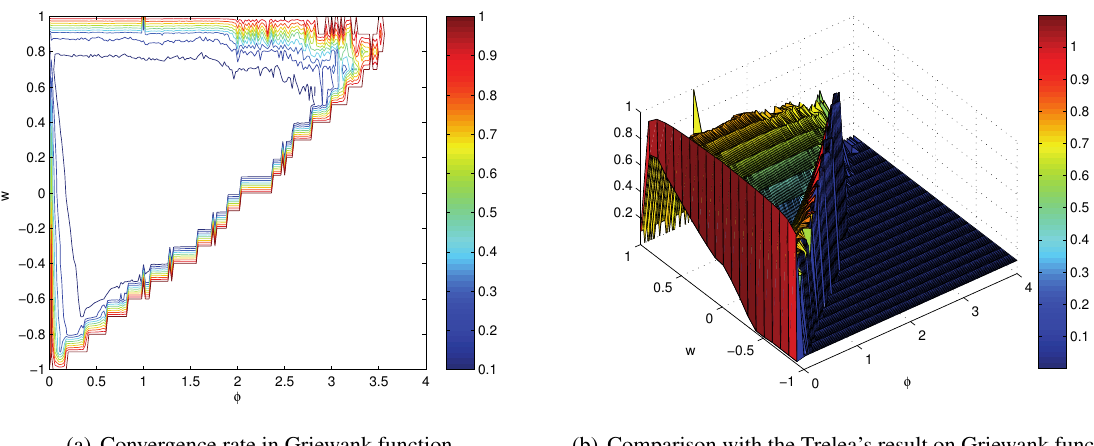
(b) Comparison with the Trelea’s result on Griewank function Figure 12: Convergence rate in Griewank function and the major discrepancy landscape between Fig. 12(a) and the right subgraph of Fig. 2 in [31] on Griewank